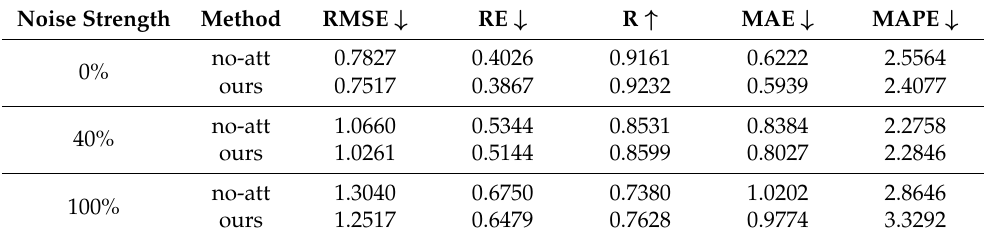
Table 12. Ablations on different noise